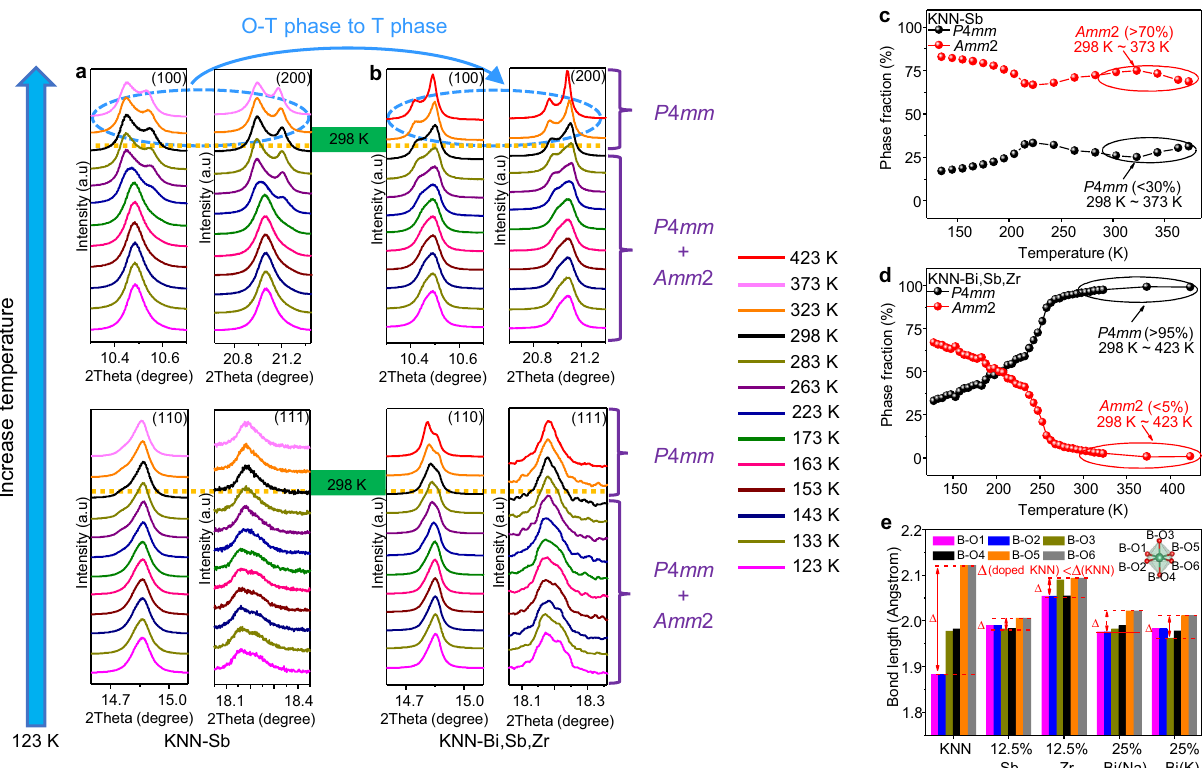
Fig. 1 Structural evolutions of the KNN-Bi,Sb,Zr and KNN-Sb ceramics. a , b Detailed pro fi les of main diffractions including (100)/(200), (110), and (111) as a function of temperature for KNN-Sb and KNN-Bi,Sb,Zr ceramics, respectively. c , d The phase fraction as a function of temperature for KNN-Sb and KNN-Bi,Sb,Zr ceramics, respectively. e The lengths of the six B – O bonds of perovskite octahedron for undoped and single element doped KNNs obtained from fi rst-principles